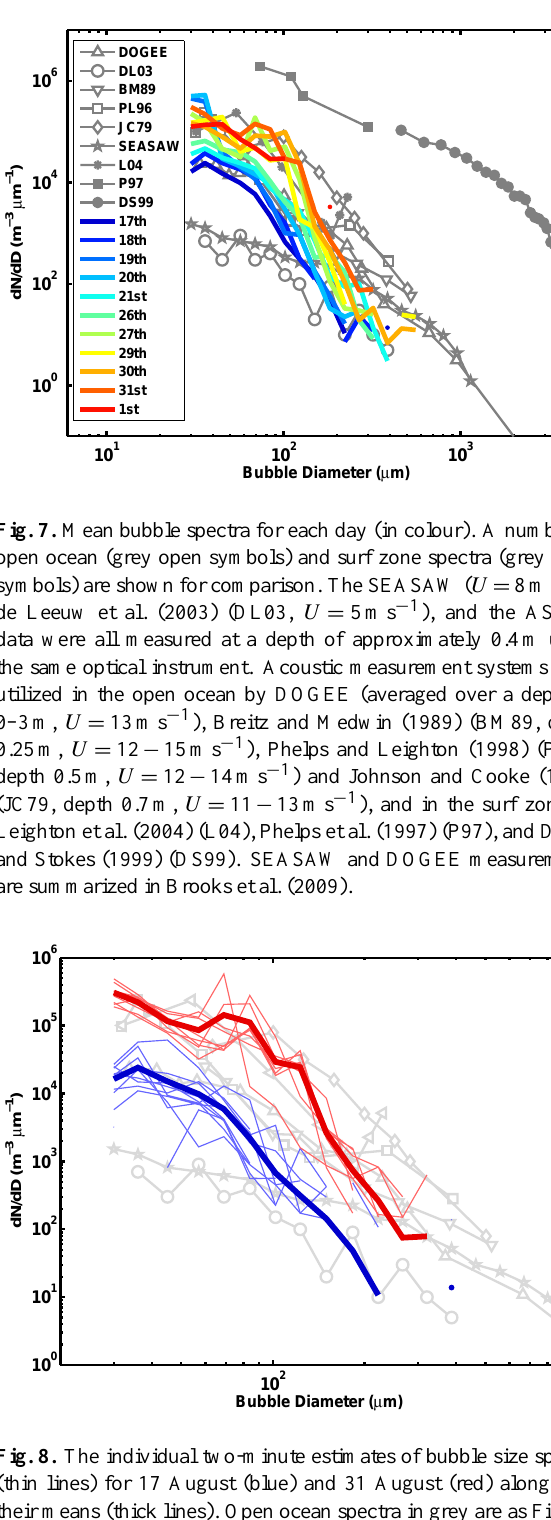
Fig. 8. The individual two-minute estimates of bubble size spectra (thin lines) for 17 August (blue) and 31 August (red) along with their means (thick lines). Open ocean spectra in grey are as Fig.